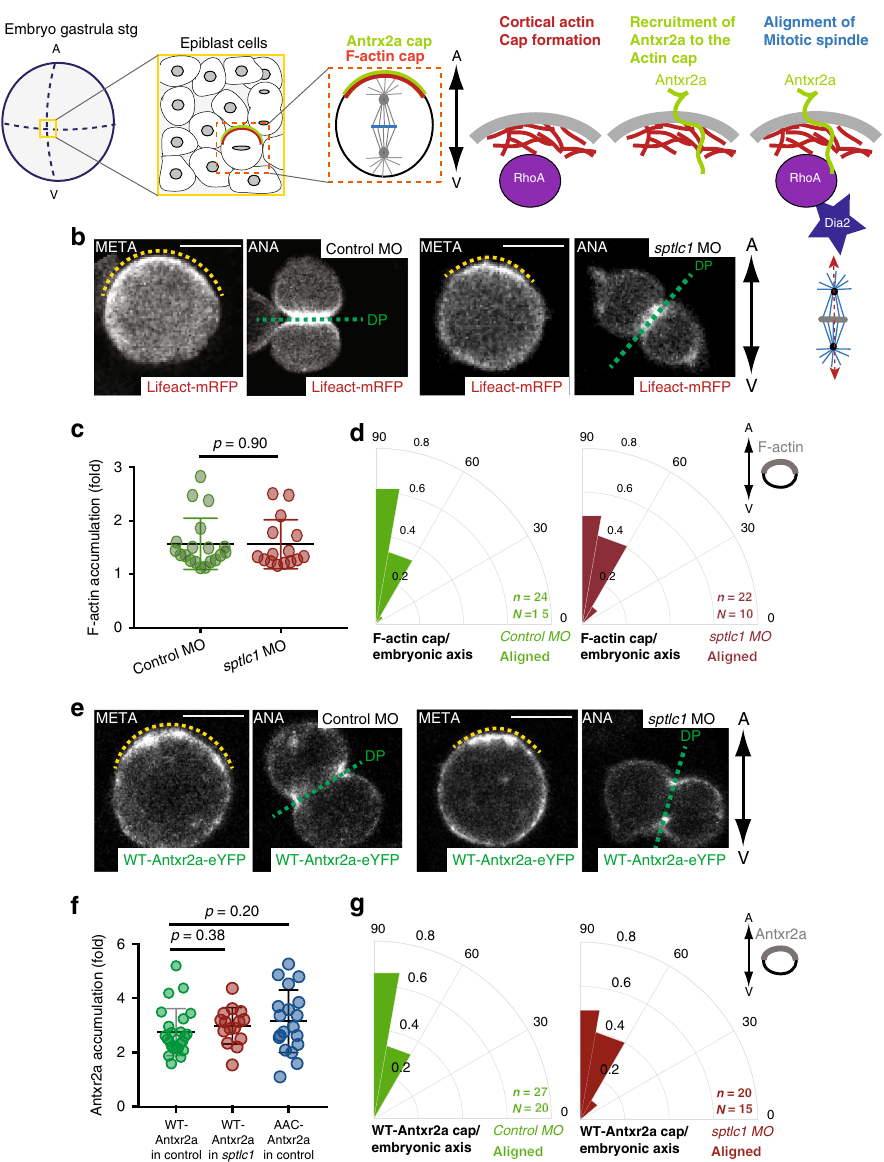
Fig. 5 Formation of F-actin and Antxr2a caps are sphingolipid-independent. a Scheme representing the three functions of the actin cytoskeleton during oriented divisions of epiblast cells 5 . In metaphase, epiblast cells form a polarized F-actin cap aligned with respect to the A/V axis. The formation of this F- actin cap depends on the small GTPase RhoA. The transmembrane protein Antxr2a binds to actin, and it is therefore recruited to and enriched at the actin cap to form a cap itself. Both caps colocalize. Antxr2a interacts then with an active form of RhoA to activate Diaphanous, which connects the mitotic spindle with the caps, rotating the spindle to align it with the caps and therefore with the embryonic axis. As a result, divisions of epiblast cells are oriented along the A/V embryonic axis. b , e Representative confocal images from a time-lapse movie of epiblast cells at metaphase (META) and anaphase (ANA) expressing the F-actin biosensor ( Lifeact-mRFP) ( b ) or Antxr2a-eYFP ( e ) in control embryos (left panels) or sptlc1 morphants (right panels) from at least ten independent experiments. Yellow dashed line highlights F-actin or Antxr2a cap. Green dashed line, division plane. Animal pole, up. The embryonic axis is represented by a bi-directional arrow on the right. Scale bars: 10 µ m. c Quanti fi cation of cortical F-actin accumulation at the cap of epiblast cells in control ( n = 19 cells; green) and sptlc1 morphants ( n = 15 cells; red) expressing Lifeact-mRFP. d , g Polar graphs showing the frequency distribution of the angle between the F-actin cap ( d ) or the Antxr2a cap ( g ) and the plane of the A/V embryonic axis in control (left graph) and sptcl1 morphants (right graph). n (number of cells analyzed) over N (number of embryos). In ( d , g ), χ 2 test was used (see Supplementary Table 1). f Antxr2a accumulation at the cap in epiblast cells expressing WT-Antxr2a-eYFP in control ( n = 24 cells; green) or in sptlc1 morphants ( n = 15 cells; red) and expressing AAC-zAntxr2a-eYFP in control morphants ( n = 19 cells; blue). Data in ( c , f ) are represented as the mean value + / − SEM and an unpaired, two-tailed student ’ s t -test was used. DP (Division plane). Source data are provided as a Source Data fi These fi ndings are based on the following key observations: (i) zygotically synthesized de novo (Figs. 1 and 2 and Supplementary lipidomics and metabolic tracer analyses revealed that down- Fig. 3); (ii) isotope tracer-based metabolomics showed that Wnt regulation of Wnt signaling results in a decrease in the levels of signaling regulates sphingolipids by modulating the activity of sphingolipids in the embryo, including sphingolipids that are SPT (Fig. 2); (iii) interfering with the sphingolipid biosynthesis